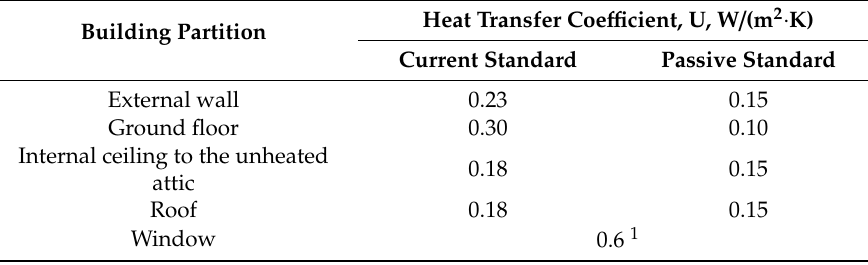
Table 1. The values of the heat transfer coe ffi cient for building